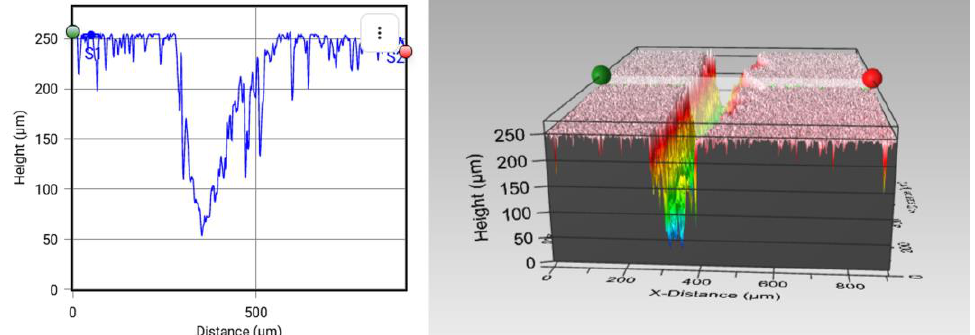
Figure 6. Initial damage created by the custom crack machine.